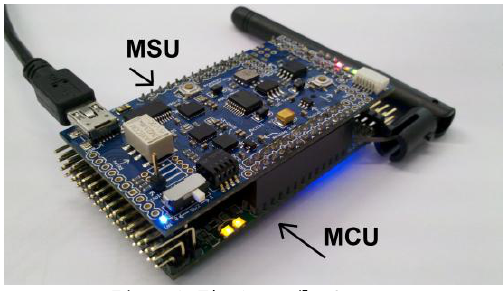
Figure 3. The Autopilot System